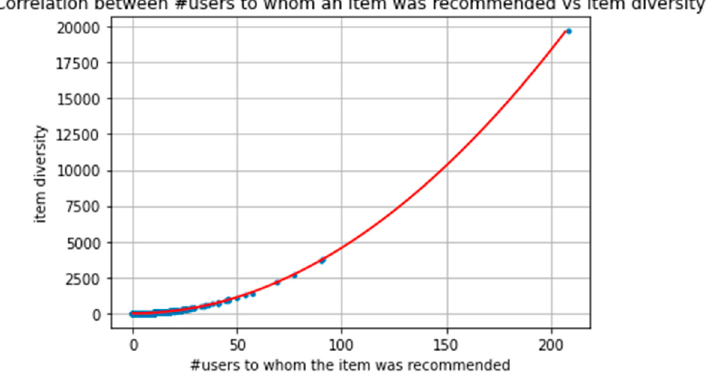
Figure 7. Relation between item diversity and number of users to whom the items were recom ‐ mended.